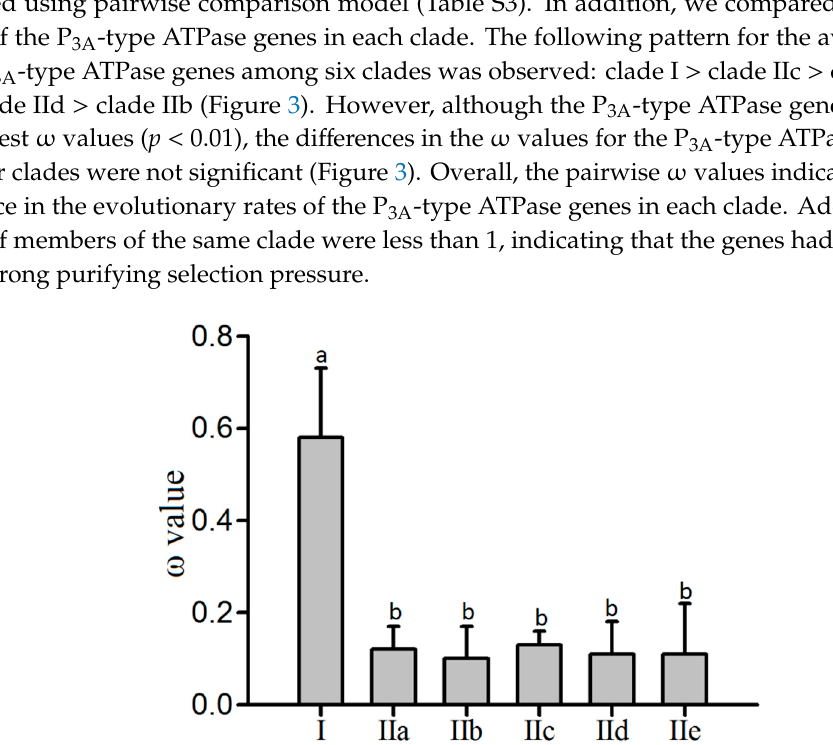
Table 2. The statistic and parameters from Branch model of PAML based on likelihood-ratio test (LRT).